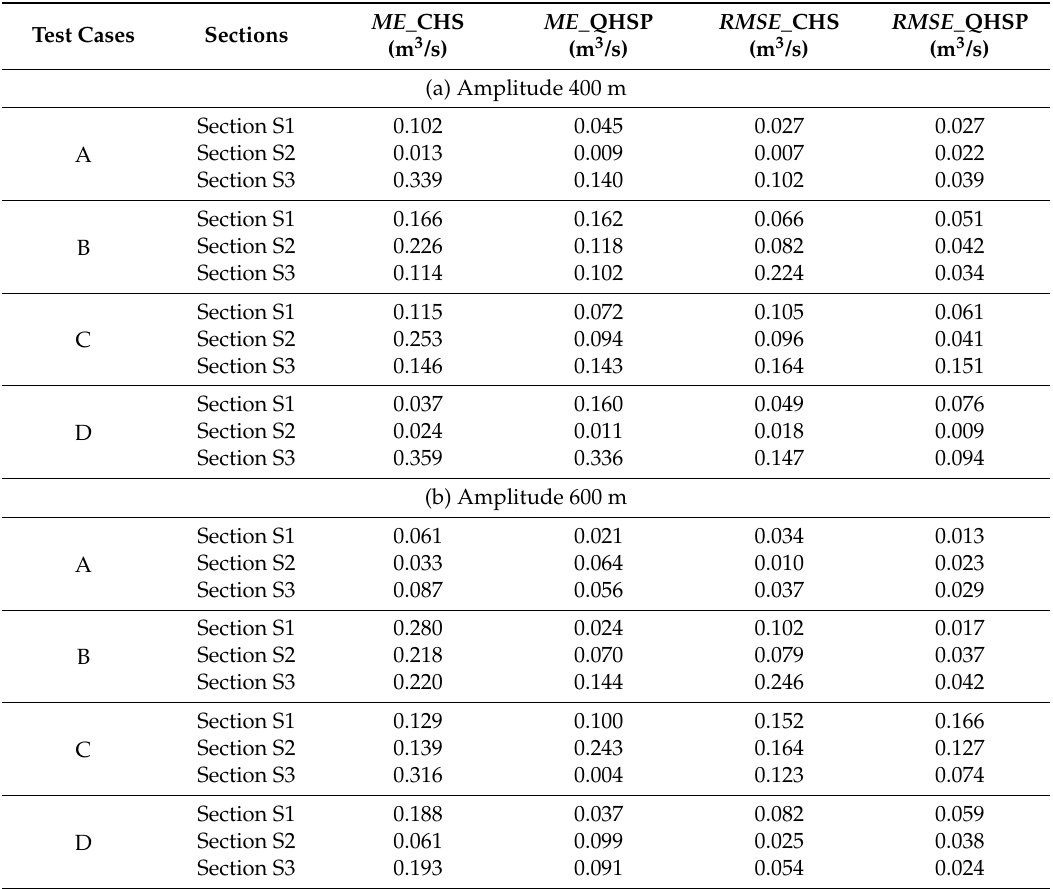
Figure 13. Computed hydrograph for test case and ( d ) D at Section S3 in the constructed river with the amplitude of 600 m. ( a ) case A; ( b ) B, ( c ) C. Table 2. Mean Error ( ME ) and Root Mean Square Error ( RMSE ) of the computed hydrograph on the constructed river bed by CHS and QHSP method.